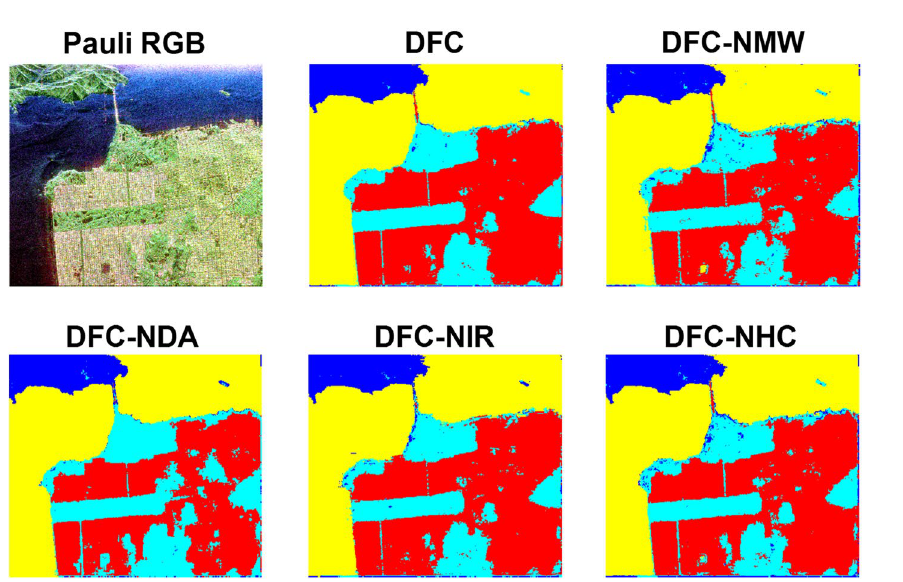
Figure 5. Pauli RGB and the achieved classification maps for SanFrancisco dataset.